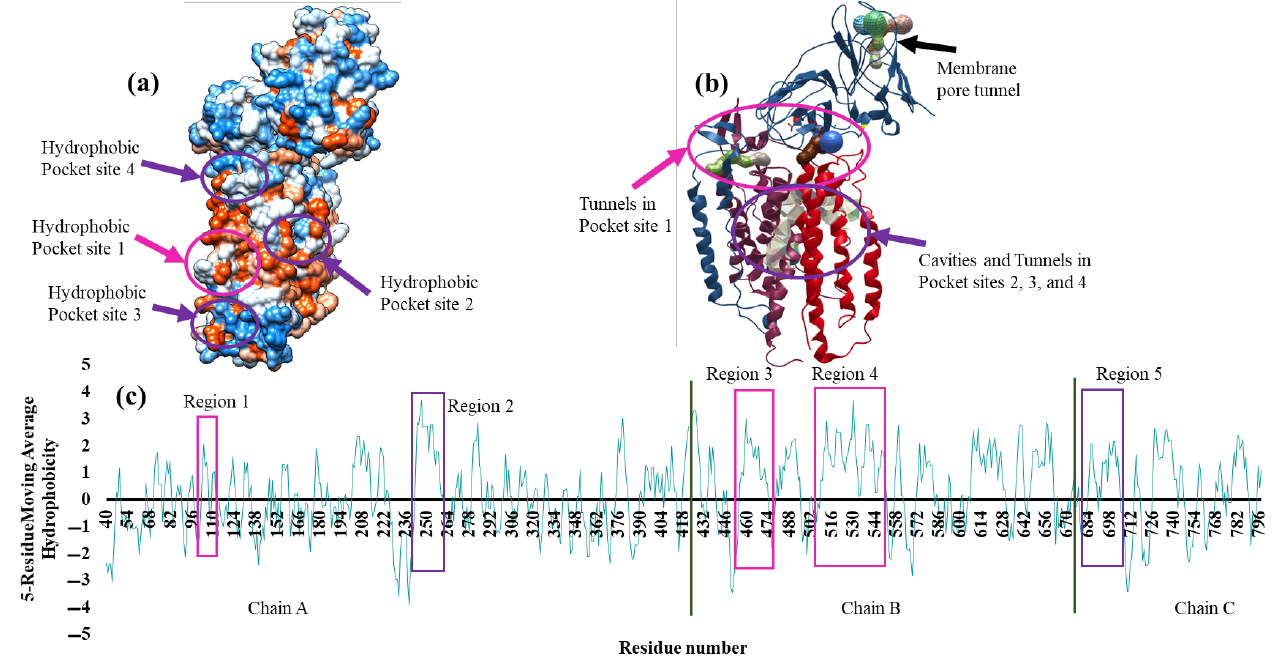
Figure 4. ( a ) The solvent accessible and nonpolar hydrophobic cavities in solid surface display; ( b ) The surface tunnel and cavities of modeled pMMO monomer. ( c ) 5 Residue Moving Average Hydrophobicity of monomeric pMMO subunits of M. trichosporium OB3b. The pocket site 1 is shown in light pink circles and rectangles, and the pocket sites 2, 3, and 4 are shown in purple circles and rectangles.